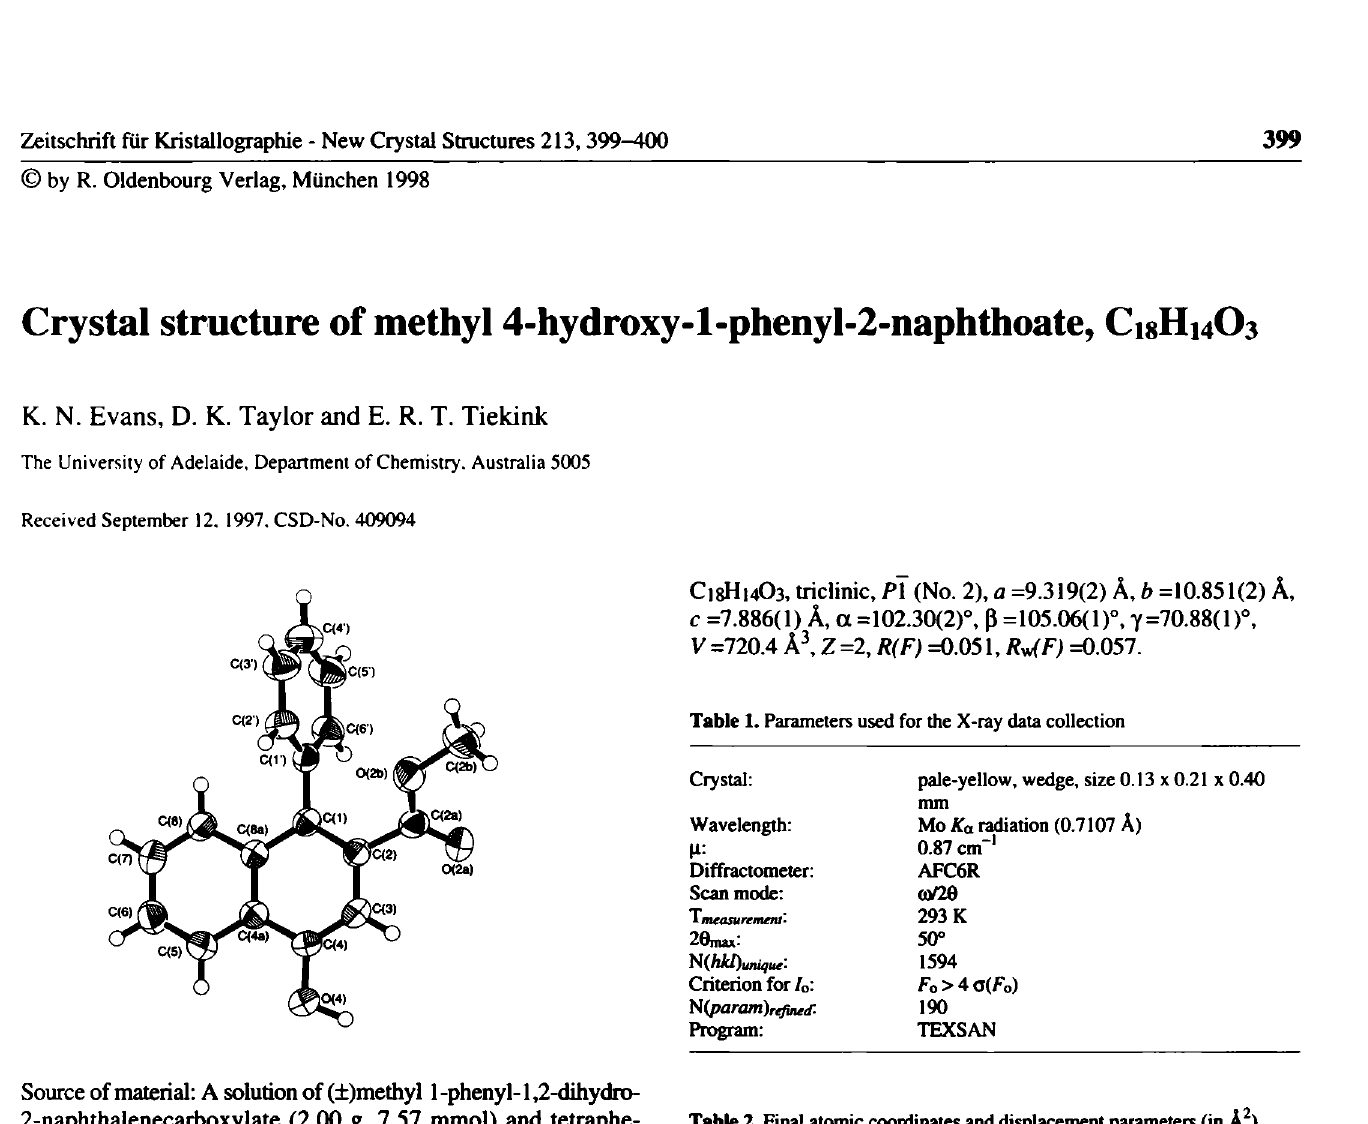
Table 2. Final atomic coordinates and displacement paiameters (in